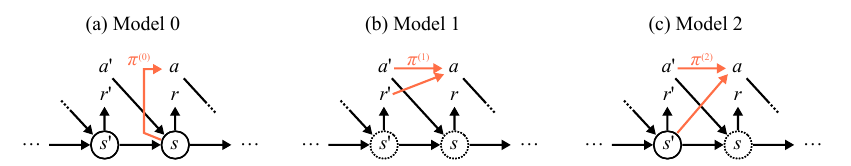
Figure 2. Different policies of the models. Depending on the given model, the agent’s decision depends on different information as indicated by orange arrows. At the present stage in which the two players are deciding actions a and r , ( a ) policy π ( 0 ) depends on the opponent’s present state s , ( b ) policy π ( 1 ) depends on the agent’s previous action a (cid:48) and the opponent’s previous action r (cid:48) and ( c ) policy π ( 2 ) depends on the agent’s previous action a (cid:48) and the opponent’s previous state s (cid:48) . The open solid circles represent the opponent’s known states, whereas dotted circles represent the opponent’s unknown states. Black arrows represent probabilistic dependencies of the opponent’s decisions and state